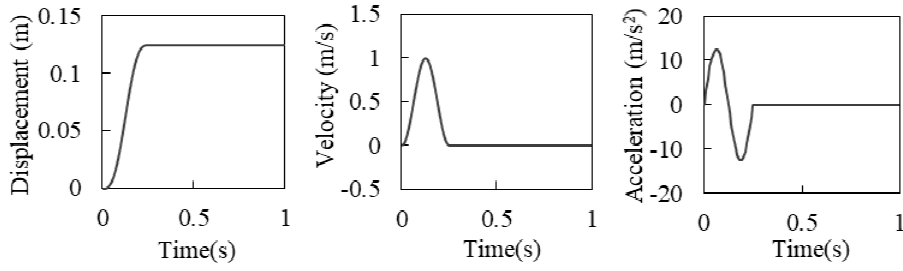
Figure 4. The input time–history curves of displacement, velocity, and acceleration. The time histories of displacement, velocity, and acceleration at each observation point (A and B, C and D, E and F in Figure 3) are calculated. Figure 5 shows the time history curves of horizontal displacement, velocity, and acceleration at position A on the free surface and position B on the bottom boundary directly below position A. It is seen that the seismic wave is input from the bottom truncated boundary, and the amplitude of the seismic wave is doubled when the incident wave reaches the free surface. The seismic wave reflected from the free surface is absorbed by the viscoelastic boundary after reaching the bottom surface, without reflection on the truncated boundary. Similar dynamic responses are observed at other observation positions (C and D, E and F).